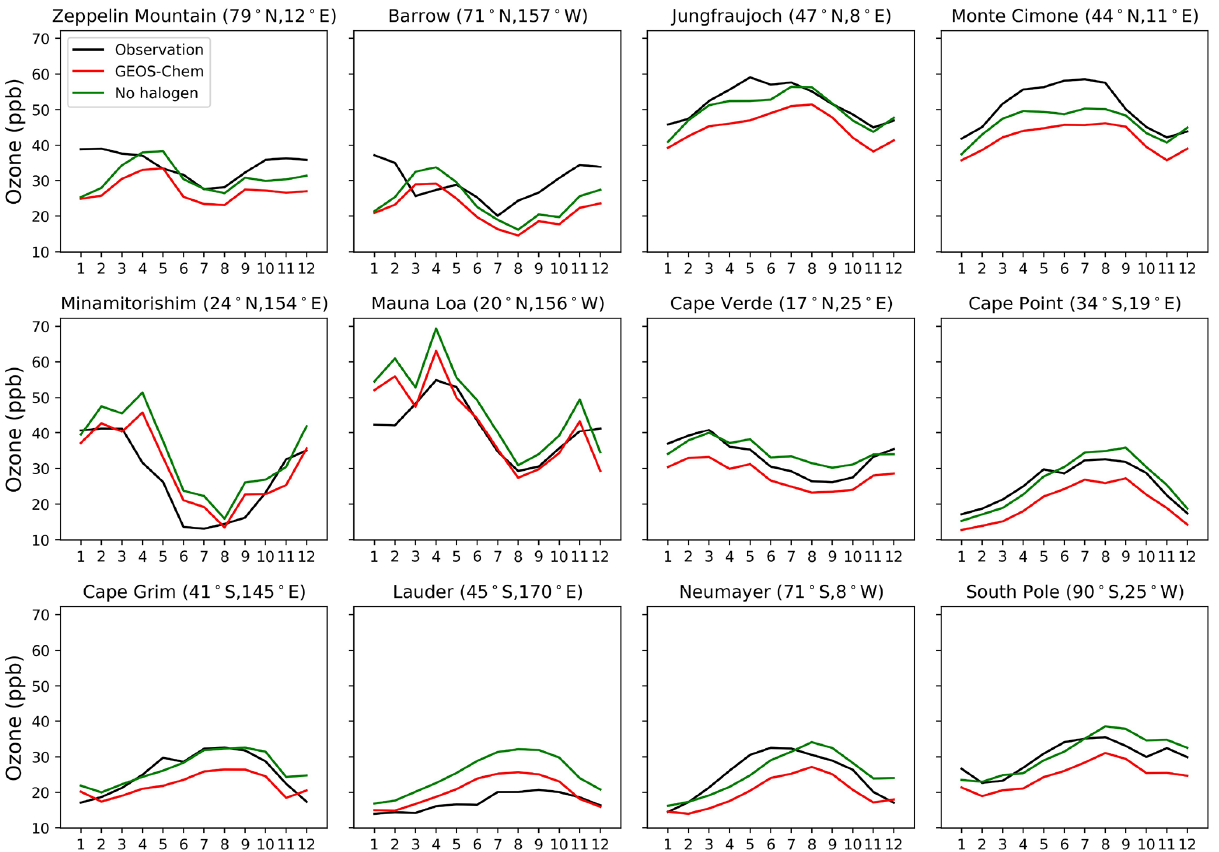
Figure 16. Seasonal variation in surface ozone at a range of Global Atmospheric Watch (GAW) sites. Observational data are from the World Data Centre for Reactive Gases (WDCRG) and are 3-year monthly averages (2015–2017). Modeled values are monthly averages for